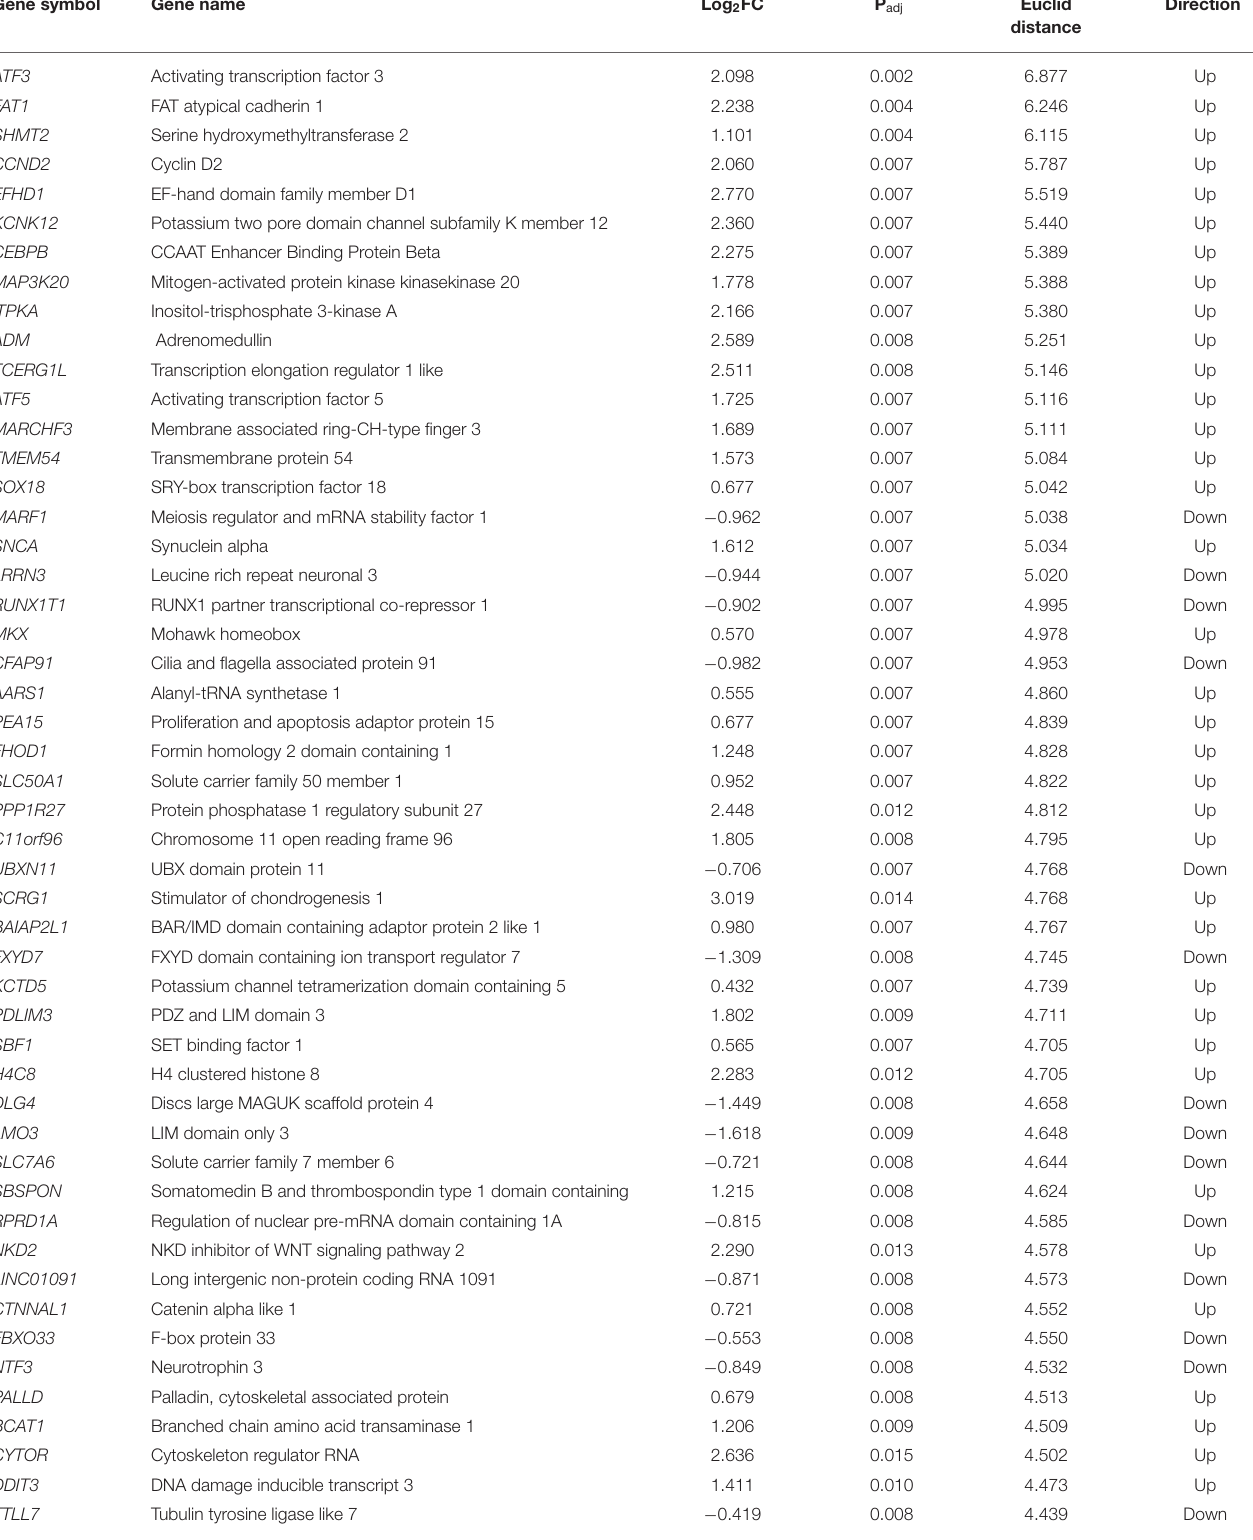
TABLE 1 | Top 50 differentially regulated transcripts between alpha-synuclein-overexpressing and GFP-expressing cells, sorted by Euclidian distance. Gene